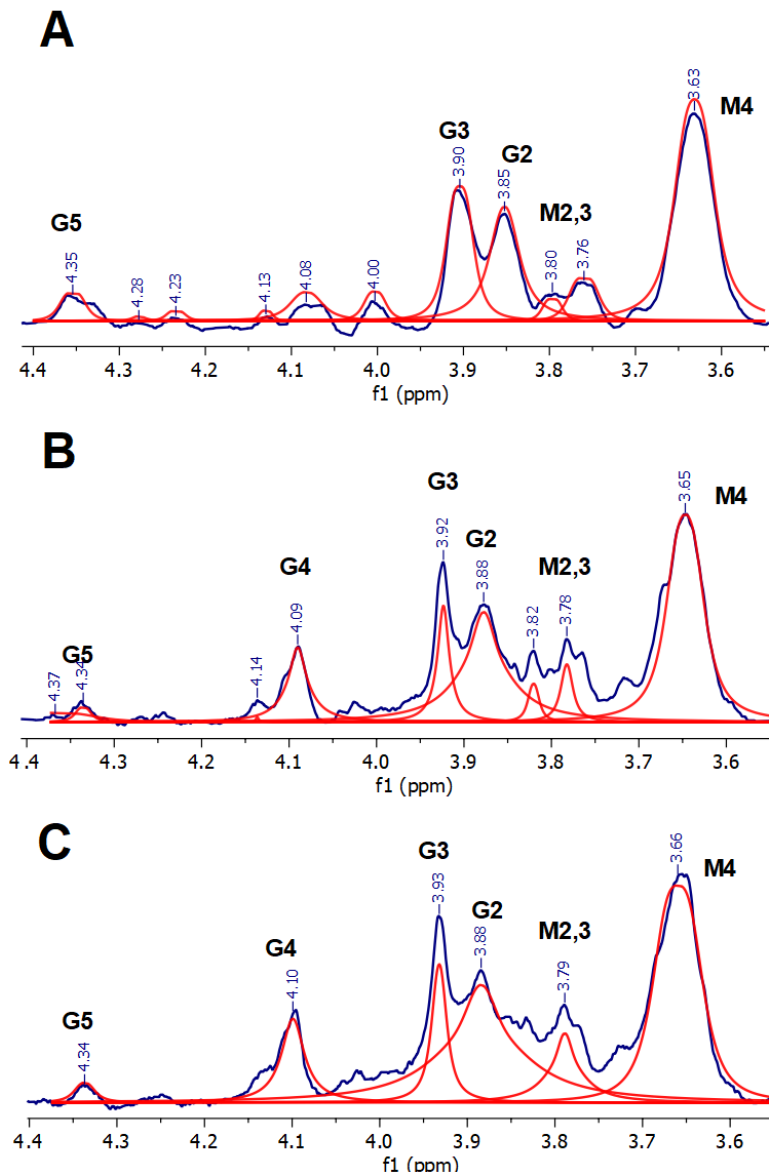
Figure 5. 1 H NMR spectra of ALG-Sr, cross-linked by different quantities (μmol) of Sr 2+ : ( A ) 0.3 μmol, ( B ) 1 μmol; ( C ) 2.5 μmol. Fitting is represented by red lines, fitting baseline is shown at the bottom.